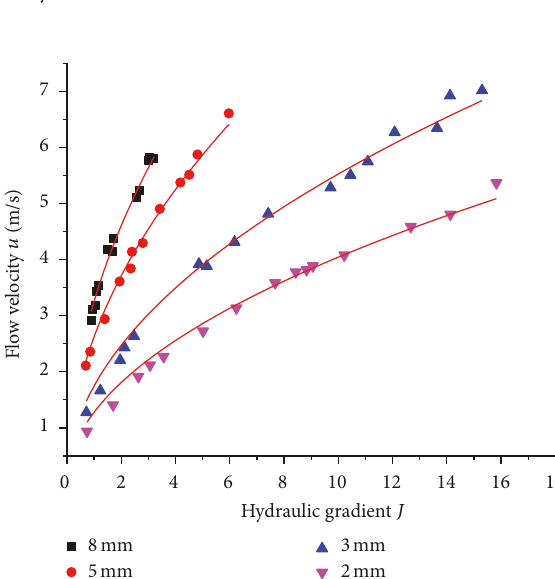
Figure 4: Experiment system.